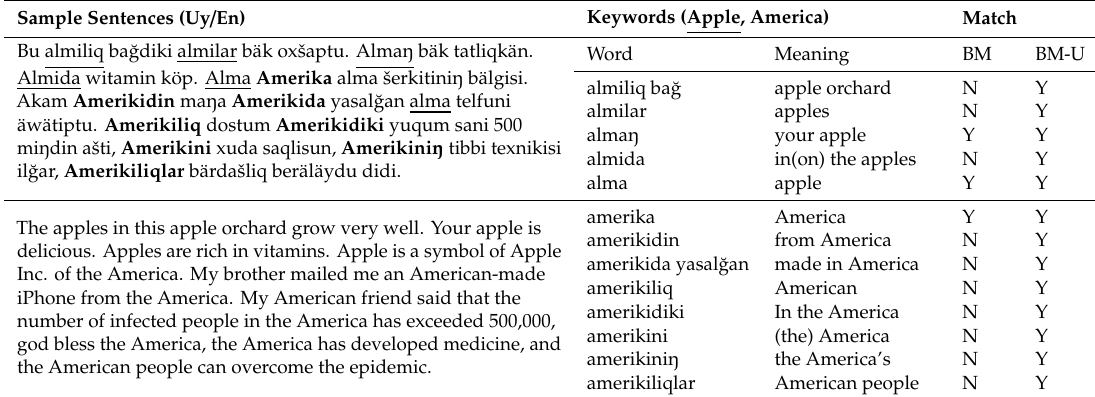
Table 9. Pattern matching results based on natural language